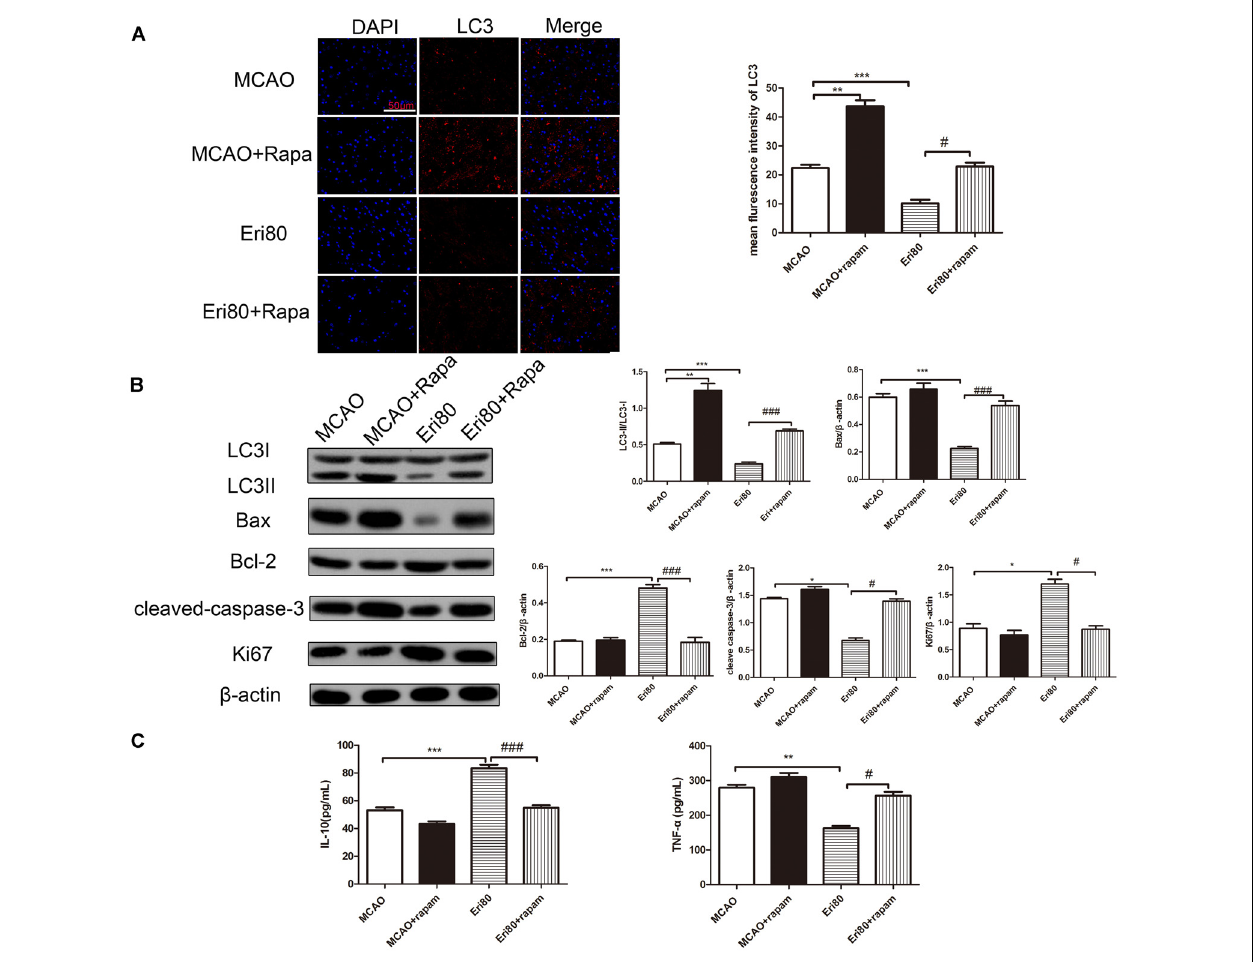
FIGURE 6 | The effects of Eriodictyol on brain injury were reversed by rapamycin. (A) The protein expressions of LC3 was detected by immunofluorescence staining. The LC3-positive signal was shown in red and DAPI was shown in blue. Scale bar: 50 µ m (vs. MCAO group, *** P < 0.001, vs. Eri80, # P < 0.05). (B) The protein expression was assessed via western blotting assay and analyzed using ImageJ software. The bands are represented for the expressions of LC3, Bax, Bcl-2, cleaved-caspase-3, and Ki67 in different groups, which were normalized to β -actin. (C) The concentration of IL-10 and TNF- α in the serum were measured using ELISA kits (The data are presented as mean ± SEM, n = 3, * P < 0.05, ** P < 0.01, *** P < 0.001, vs. MCAO group; # P < 0.05, ### P < 0.001, vs. Eri80